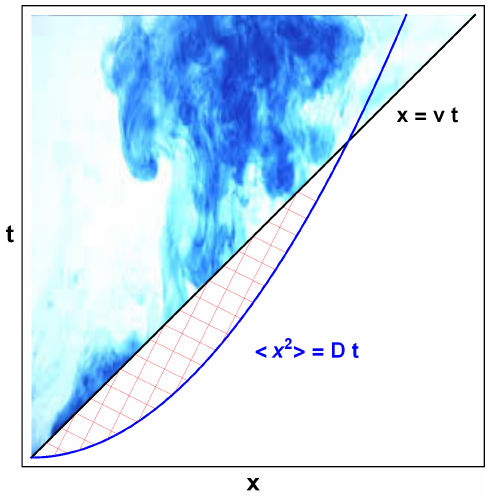
Figure 6: A simple visual derivation of the upper bound on diffusion imposed by causality. v here is the lightcone speed. Figure adapted from [ 15 ]